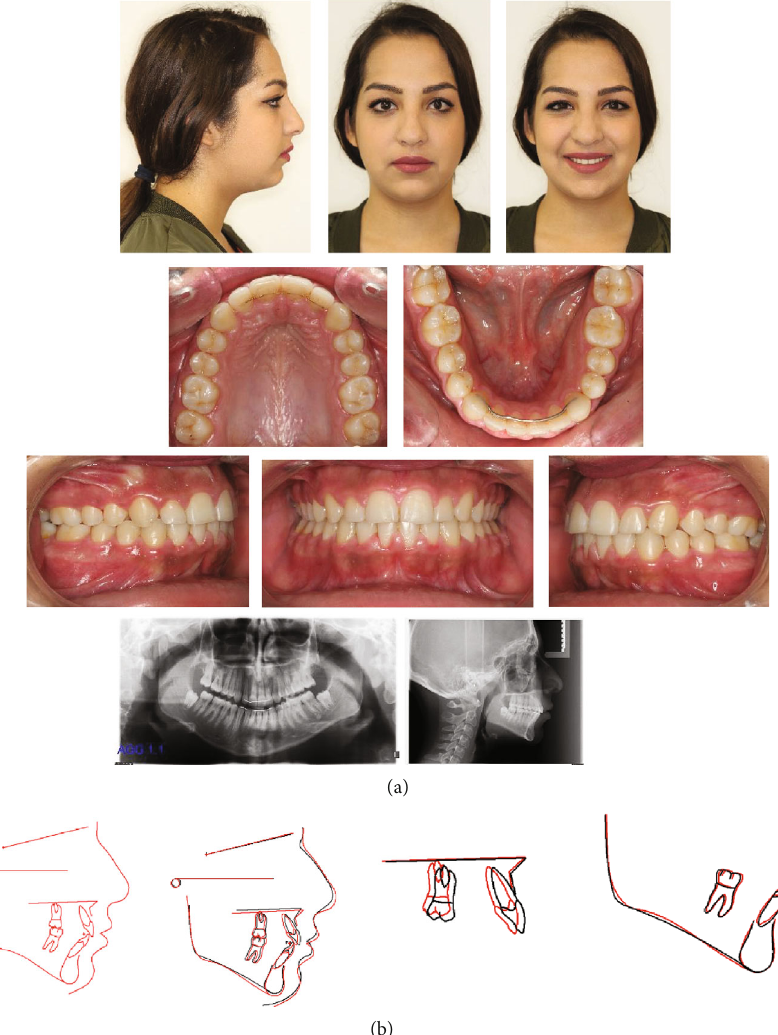
Figure 9: Case 1. (a) Patient after 18 months of treatment. (b) Superimposition of pretreatment (black) and posttreatment (red) cephalometric